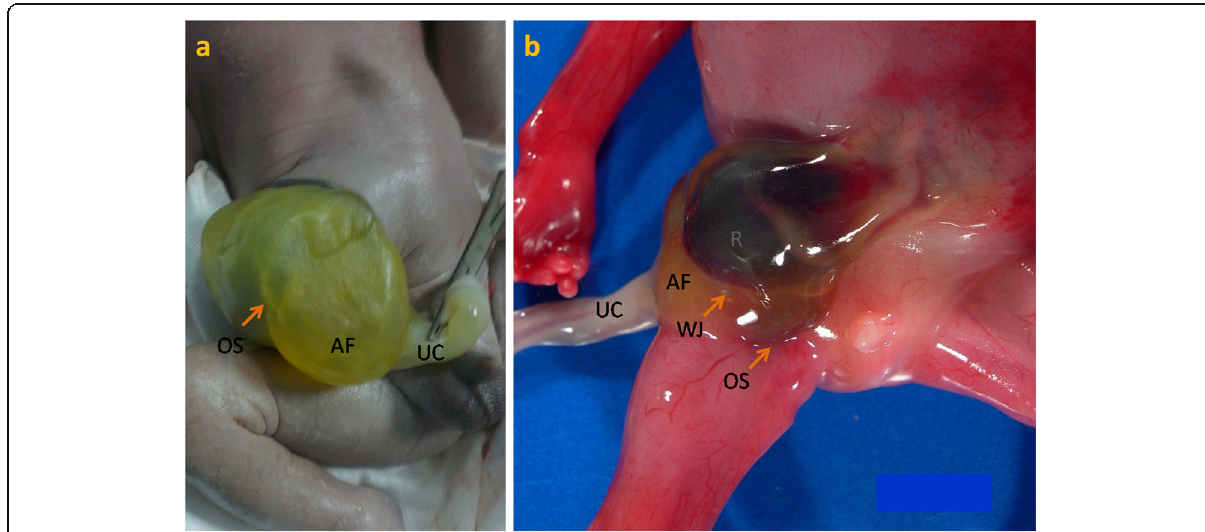
Fig. 1 Intact central omphalocele. a Isolated omphalocele in male liveborn Congolese infant (before surgery): medium-sized omphalocele covered with a thin sac (os) of membrane containing the amniotic fluid (AF, yellow) and the intestines. Umbilical cord (UC) inserted into the